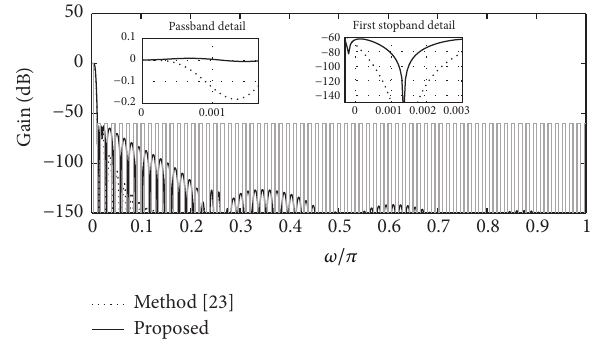
Figure 4: Magnitude responses of the filters 𝐻 𝑎 (𝑧) (method [23]) and 𝐻 𝑏 (𝑧) (proposed method), presented in Example 2 with 𝑀 = 𝑀 = 8 ∗ 17 = 136 , 𝜐 = 2 , and 𝜔 𝑀 1 2